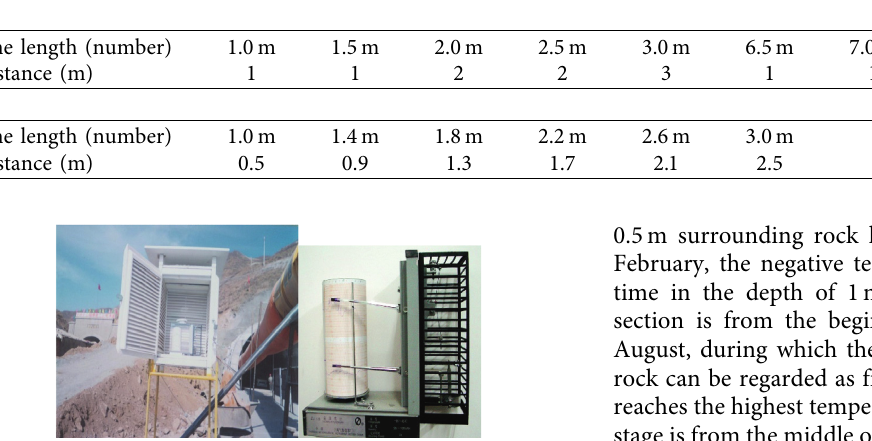
Figure 5: Distribution of thermometric elements. (a) Field installation of temperature sensors. (b) The radial distribution of thermometric elements. (c) Distribution of thermometric elements in longitude along the tunnel. Table 1: The distance between thermometric elements and the liner surface.